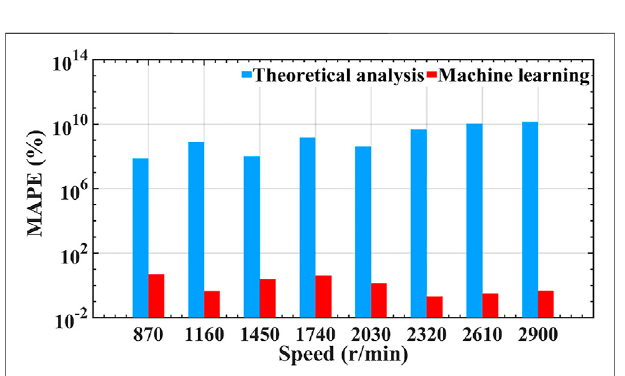
FIGURE 12 | Comparison of maximum isentropic ef fi ciency under all working conditions.